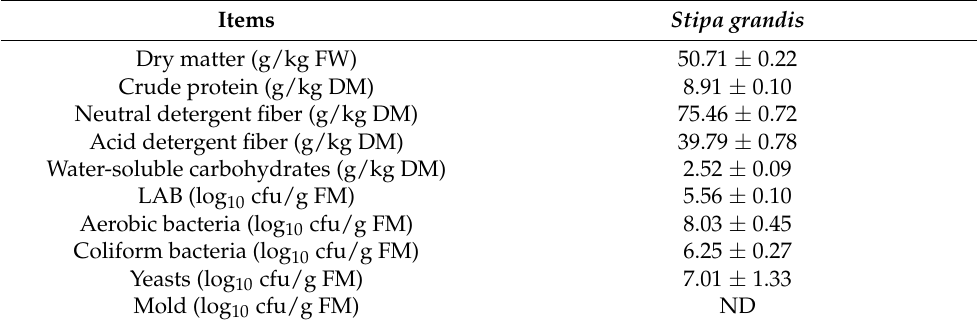
Table 4. Chemical and microbial compositions of substrates before